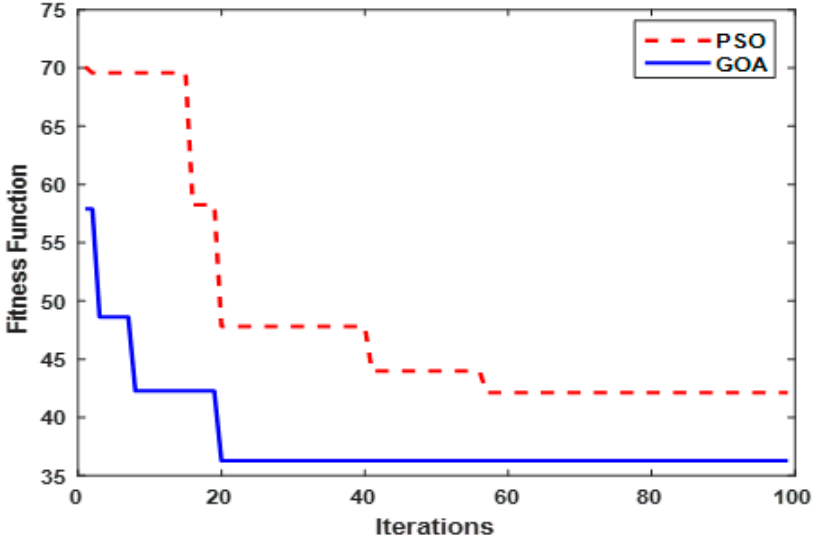
Figure 9. Convergence curve for particle swarm optimization (PSO) and grasshopper optimization algorithm (GOA).